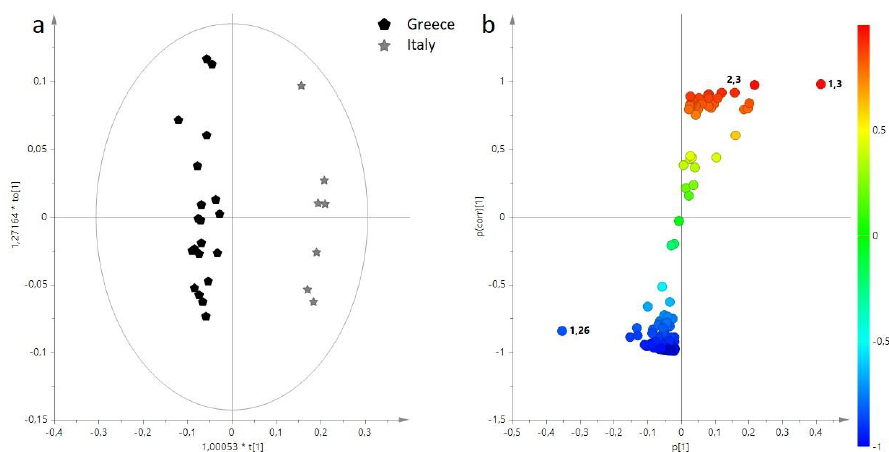
Figure 2. ( a ) OPLS-DA t[1]/to[1] PCA score plot performed on major components (BUCKET-1) of Koroneiki EVOOs samples obtained from Greece and Italy, ( b ) S-plot for the OPLS-DA model colored according to the correlation-scaled loading vector (p(corr)). The variables indicated the chemical shift value (ppm) in the 1 H NMR spectrum.